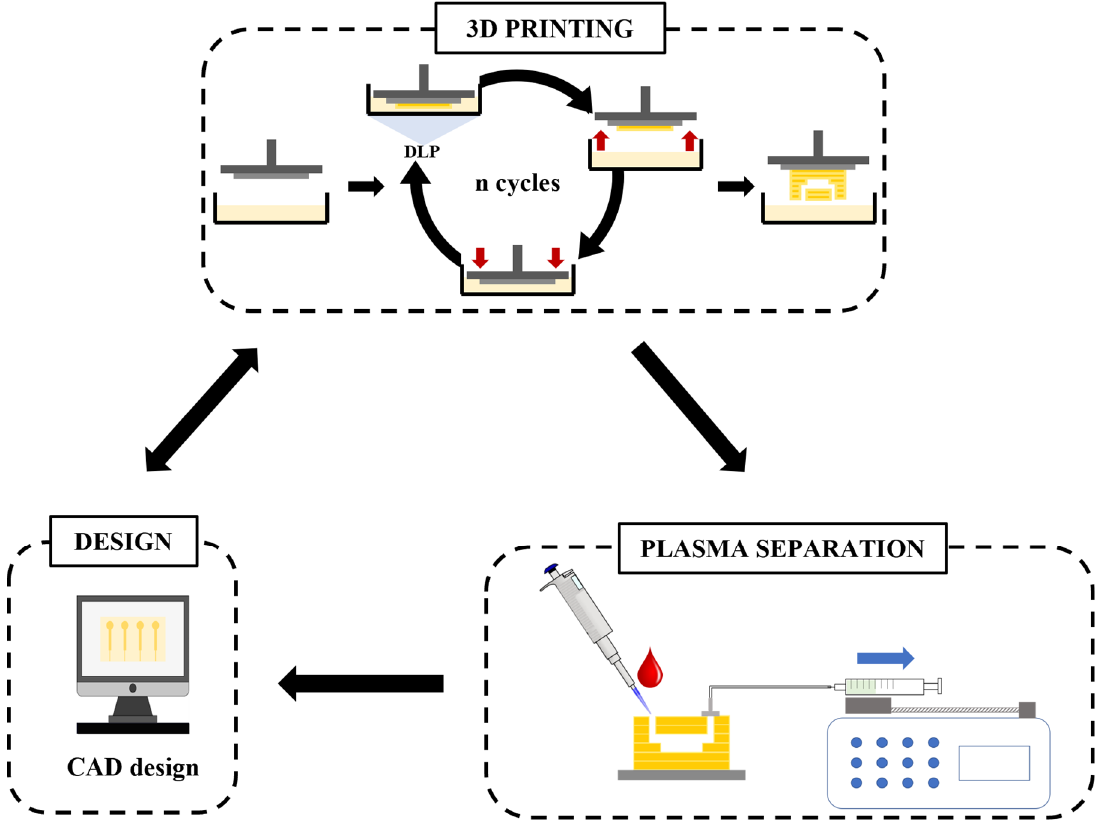
Figure 1. Workflow of the iterative fabrication process and the application of the fabricated micro ‐ fluidic devices for plasma separation. The first step was the design of the devices through CAD software. Then, these models were 3D printed using a high ‐ resolution, custom ‐ made 3D printer with custom ‐ made resins. This allowed fast fabrication times, thus the CAD designs could be easily modified based on the fabrication ‐ and ‐ fail optimization method, which allowed the development of an iterative fabrication process until obtaining an optimum device.